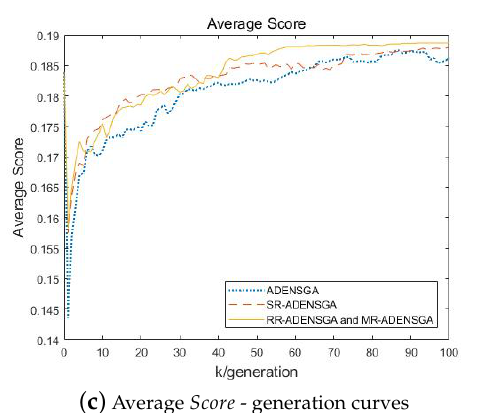
Figure 7. Comparison of Optimization Results of Different Algorithms Changing With Generation in Situation 2.